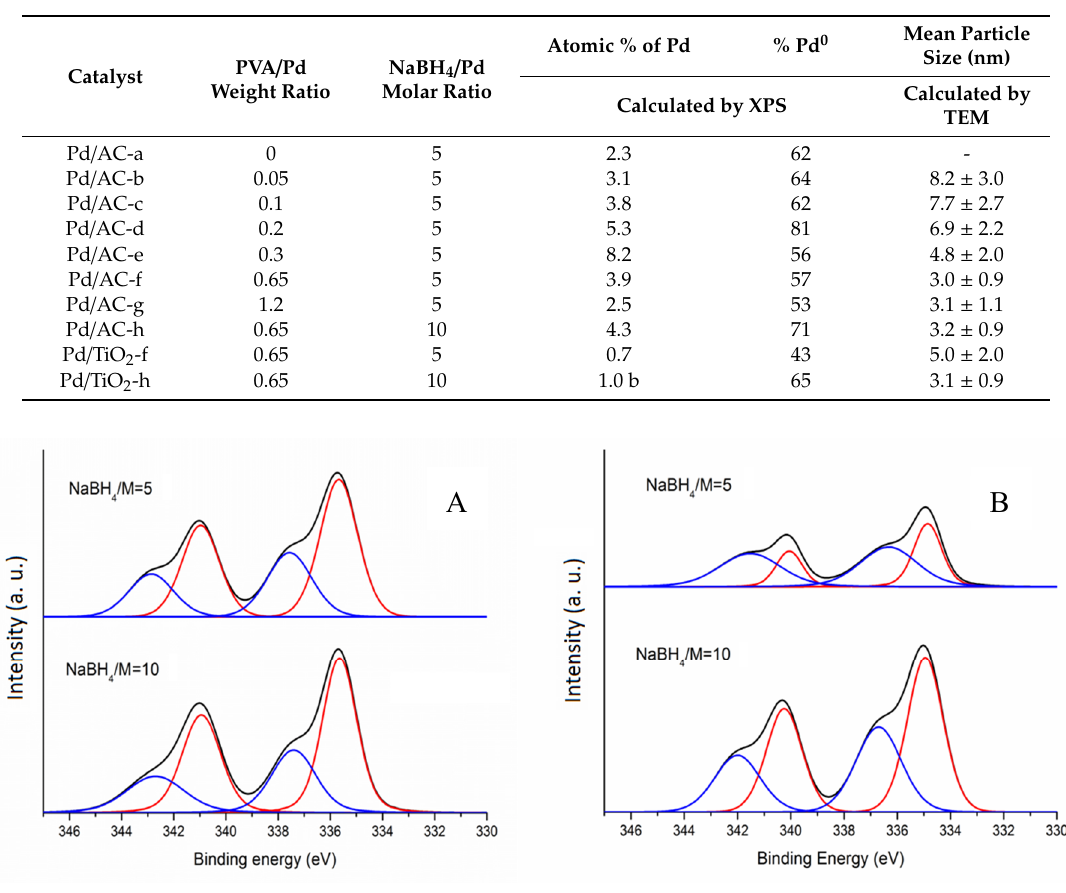
Figure 1. XPS spectra of ( A ): Pd / AC-f and Pd / AC-h and ( B ): Pd / TiO 2 -f and Pd / TiO 2 -h. Table 1. Palladium atomic content at the surface, % Pd 0 and mean particle size.